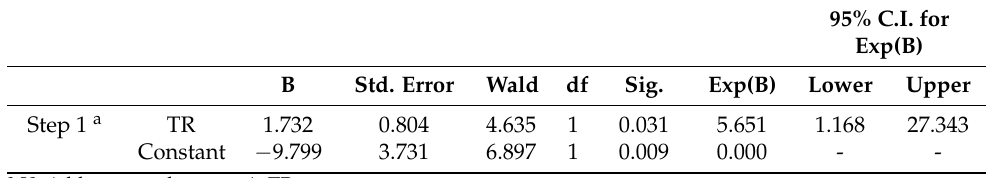
Table 17. Technology readiness: regression analysis for community.